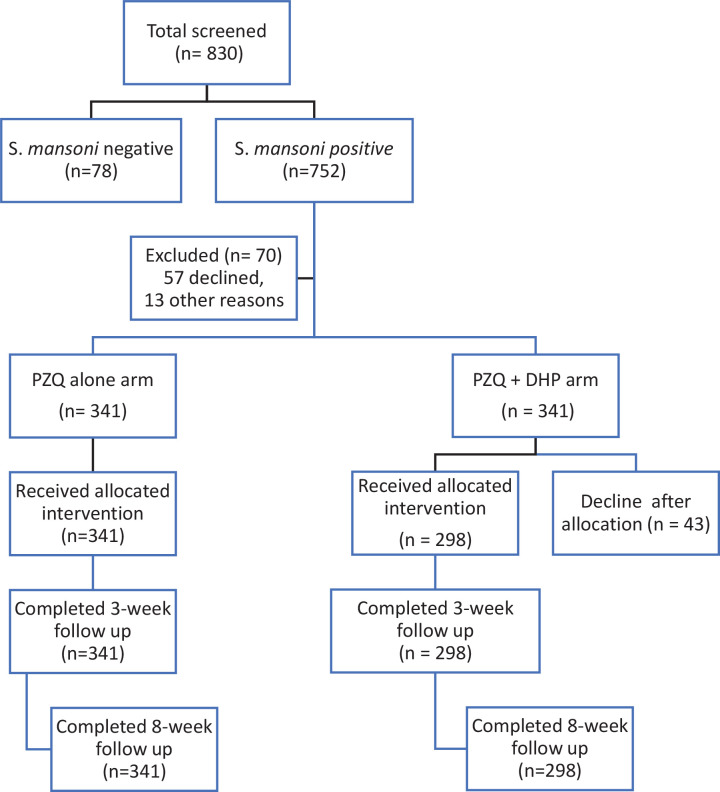
Study flow chart showing screening, treatment allocation, and study follow-up.